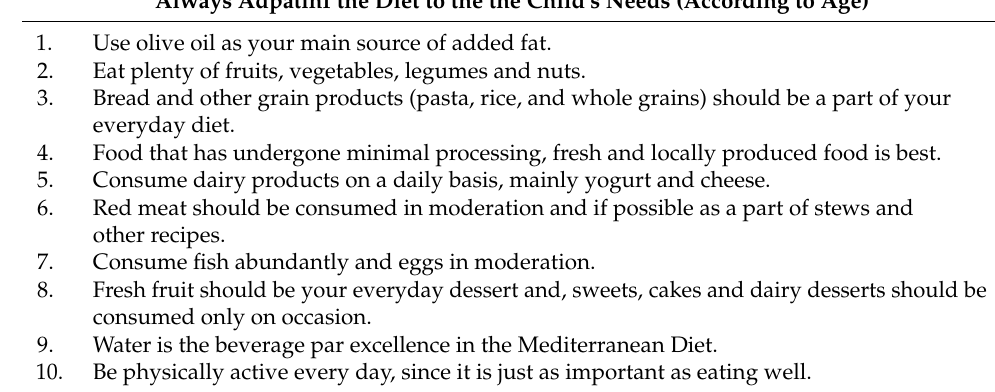
Table 2. Mediterranean diet. Ten basic recommendations.